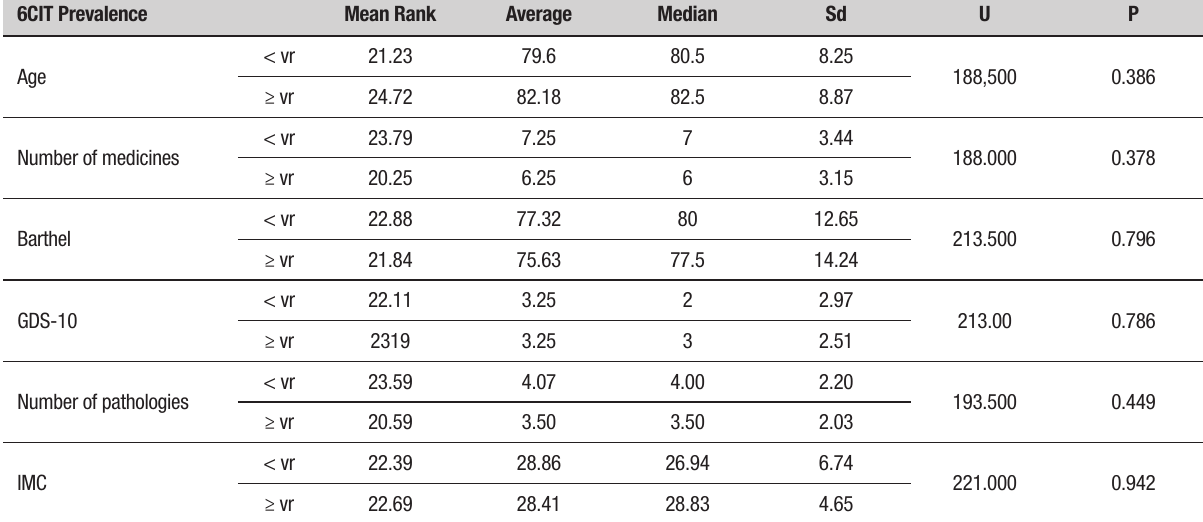
Table 2. Results of the application of the Mann Whitney U test in the variables age, number of medications, number of diseases, dependence index, BMI and number of depressive symptoms by group of individuals according to the presence or absence of